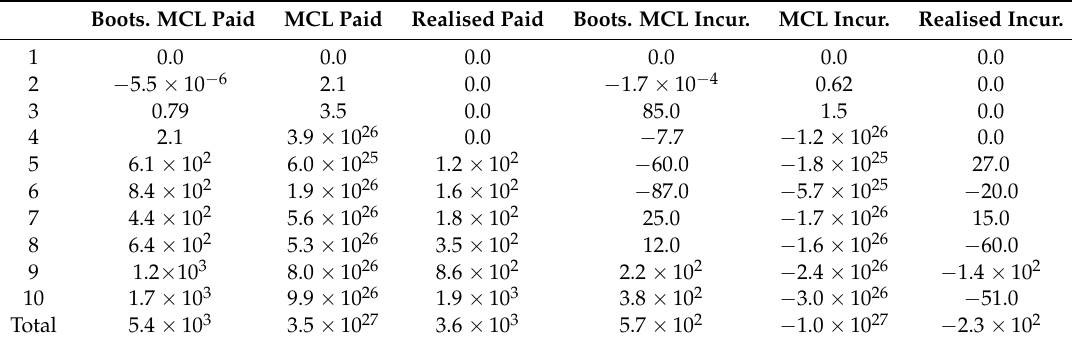
Table 8. Paid and incurred estimates divided into accident years (bootstrapped MCL, original MCL and actual). Data used from commercial auto, group code